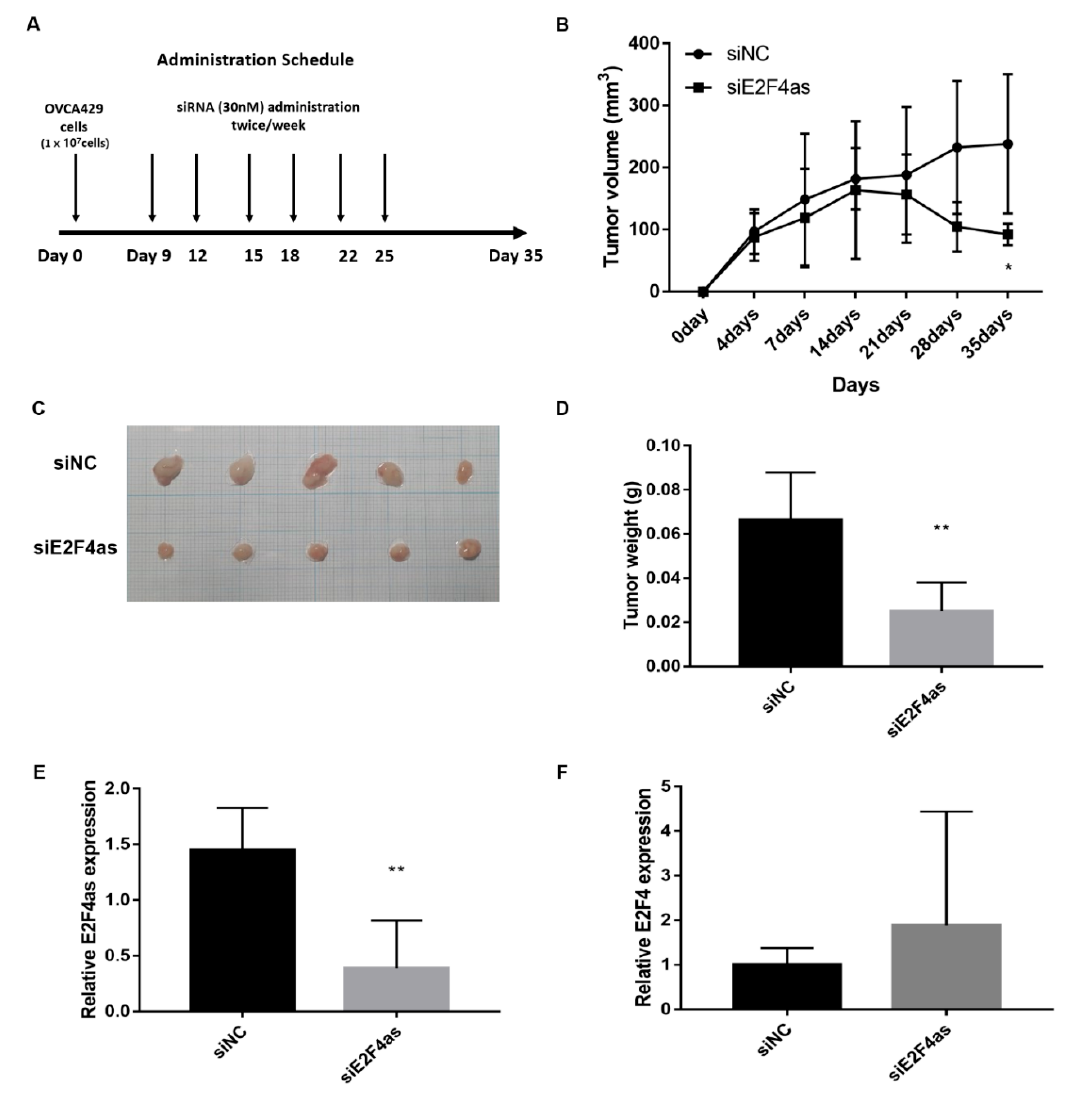
Figure 6. Lnc E2F4as inhibited OVCA429 tumour growth in vivo. ( A ) Flowchart of the experimental protocol for the xenograft model. OVCA429 cells (1 × 10 7 ) were injected subcutaneously into Balb / c-nude mice with an equal volume of PBS. When tumours had formed 100 mm 3 later, injected intratumoural siRNA. ( B ) Tumour volumes were calculated from calliper measurements. ( C ) Photograph of tumours are presented. ( D ) Tumour weight. Data are expressed as mean SD ( n = 5). ( E ) The expression of E2F4as was measured by qRT-PCR in xenograft model tumour tissues * p < 0.05, ** p < 0.01 vs. siNC. ( F ) The expression of E2F4 was measured by qRT-PCR in xenograft model tumour